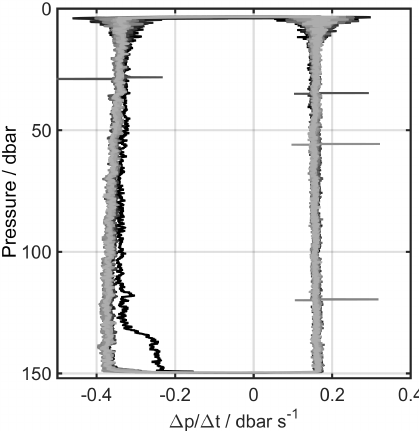
Figure 5. Ascent speed (in bar s − 1 ) for the 17 profiles of the first deployment. Profiles are colour-coded, changing gradually from the first profile in black to the last one in light grey.